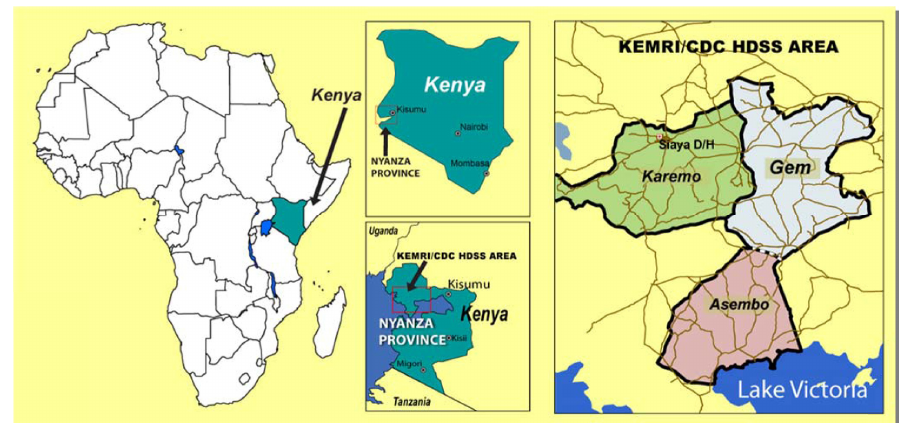
Figure 1. Area of study: Gem District in Siaya County, Nyanza Province,